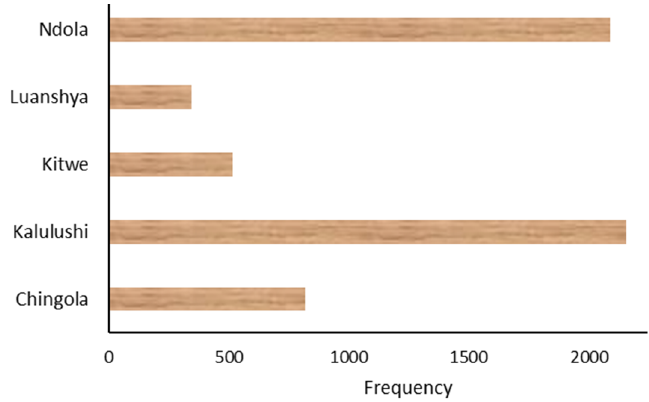
Figure 16. Frequency of clear cuts in forest reserve category in different districts.